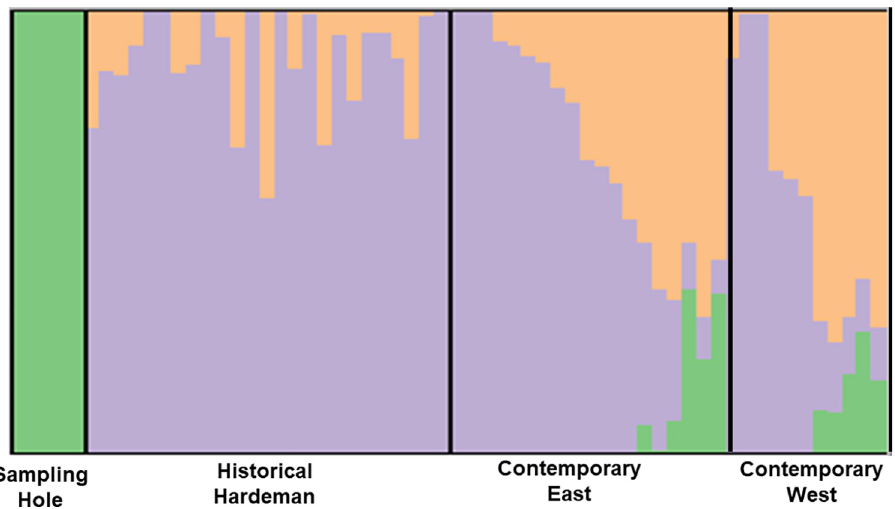
Fig 3. STRUCTURE plot of 60 D . elator samples across three time periods (see text for time breakdown). The “sampling gap” individuals, those that were found in the areas of Wilbarger and Baylor counties prior to 1980, are completely divergent from later samples;. These results show greater admixture among contemporary subpopulations, though there appears to be some structure in the contemporary east and west samples.